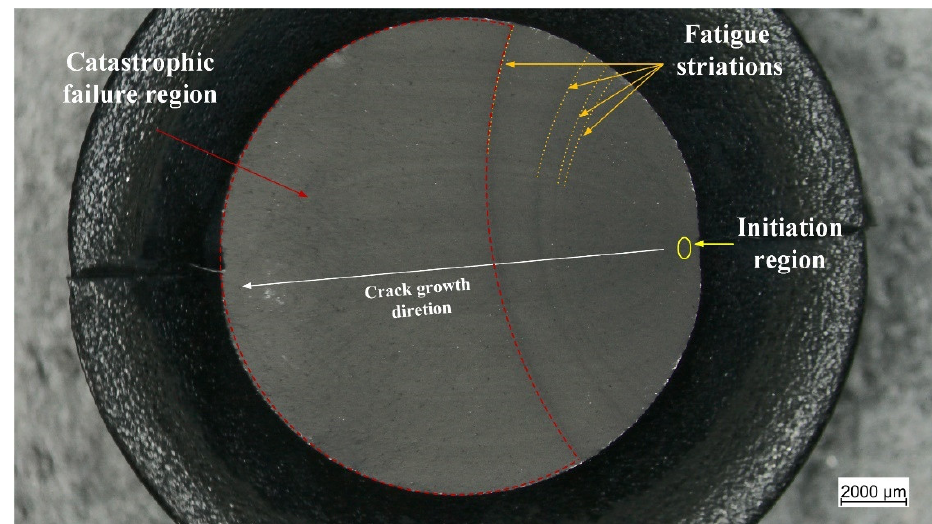
Figure 9. Light microscope picture of the fracture surface of an axisymmetric dumbbell specimen of CB filled NBR after fatigue testing. Three regions are displayed: initiation region (yellow), fatigue striation (orange), and catastrophic failure (red). The test was performed at a frequency of 4 Hz and a load ratio R ε of 0.5.